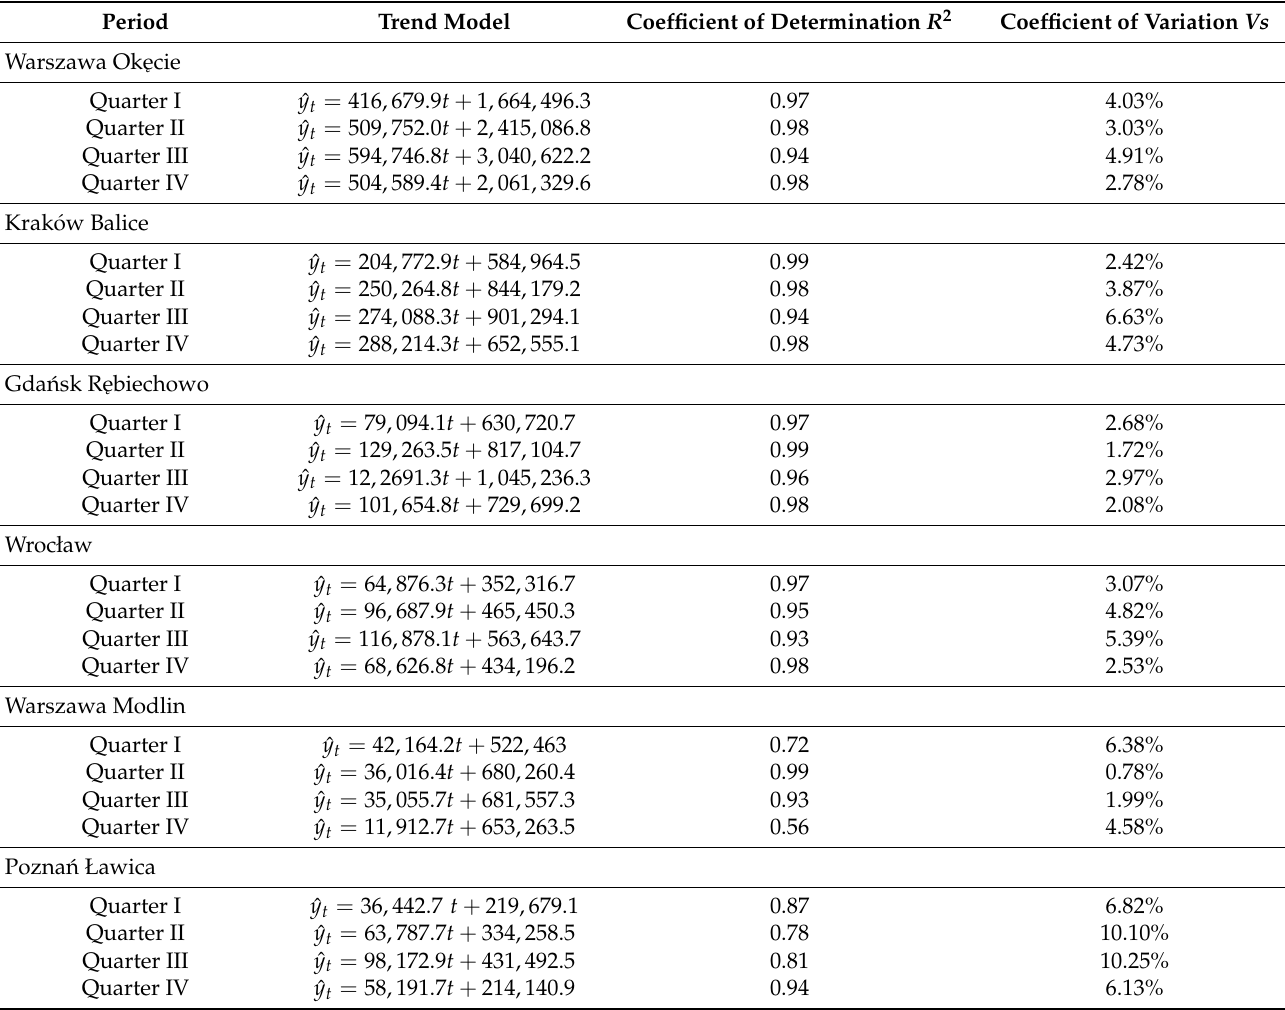
Table 5. Trend models for homonymous periods.